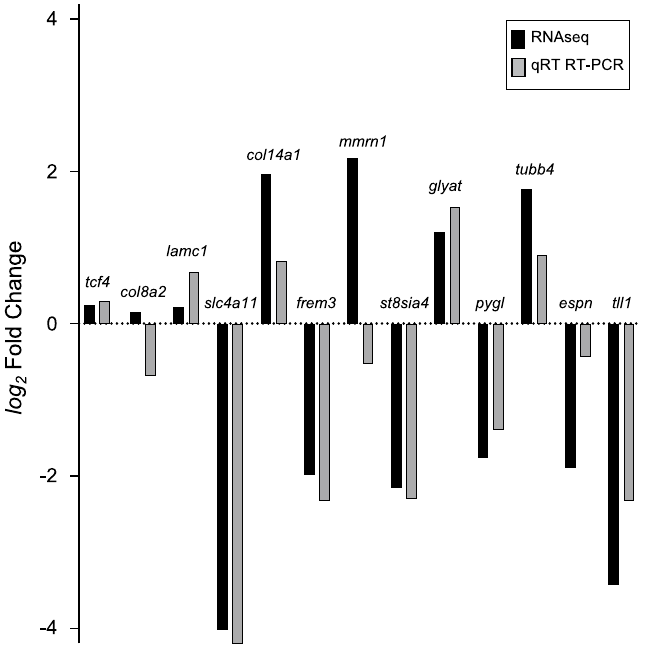
Figure 5. Comparison of RNAseq and qRT RT-PCR data. Mean values of RNAseq and qRT RT-PCR corresponding to different genes analyzed on slc4a11 + / + and slc4a11 −/− mice cornea were converted to log 2 fold change and used to verify the two